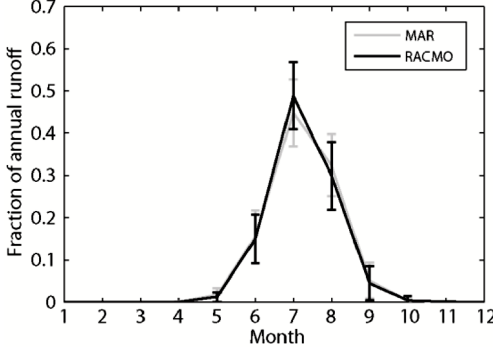
Figure 2. Fraction of annual runoff occurring for each month as given by MAR and RACMO2 SMB models for KNS and AS be- tween 1960 and 2012 (Van As et al., 2014). Error bars are given to 2 standard